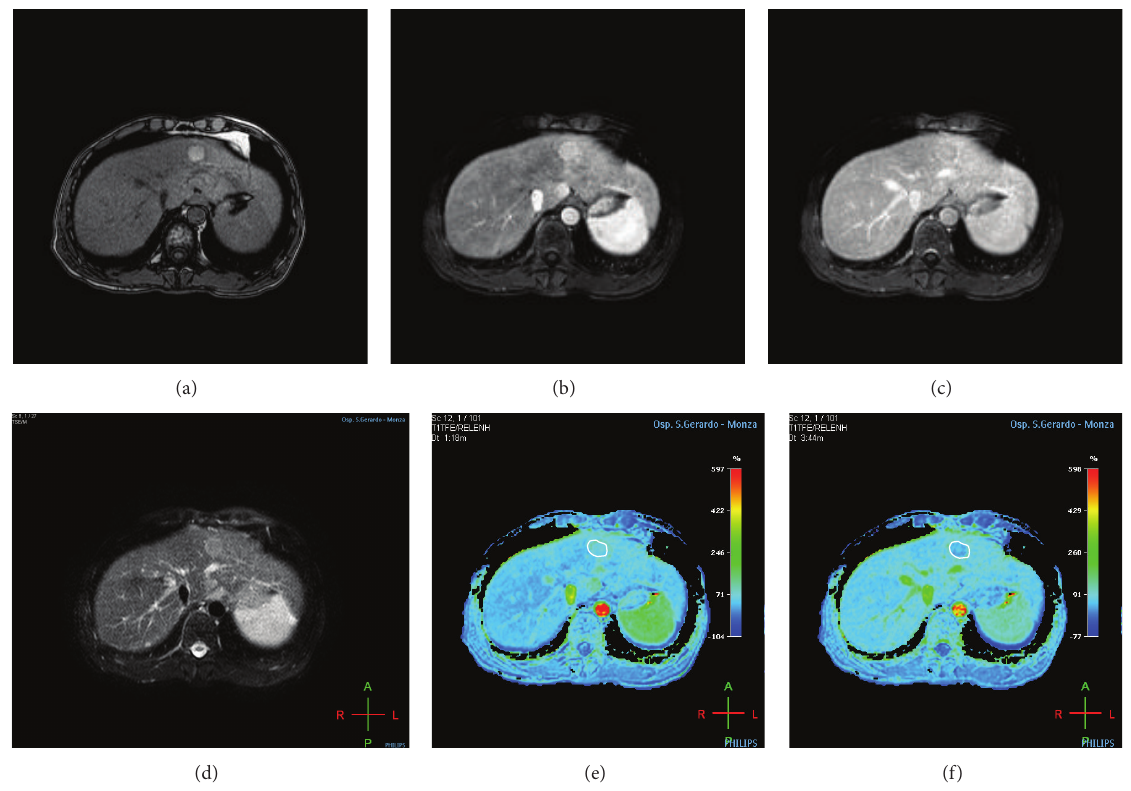
Figure 3: An 81-year-old man with liver cirrhosis-HCV related and with histologically proven HCC in the second segment. DCE-MR was performed to establish the presence of focal liver lesion. (a) Axial T1-weighted in-phase echo-gradient sequence shows a hyperintense nodular area in the second segment, due to presence of glycogen deposition. (b, c) Axial arterial and delayed postcontrast phase MR images show in arterial phase the presence of increased enhancement of nodular lesion, followed by washout in delayed phase. (d) Axial T2 fat-sat weighted sequence shows a weakly hyperintense nodular area in the second segment. (e, f) On colour perfusion maps (Relative Arterial Enhancement and Relative Late Enhancement, resp.) the ROIs (ROI contouring the boundaries of the lesion) were positioned on nodular lesion, and the corresponding perfusion maps show a hypervascular area, characterized by a different colour compared to the surrounding liver parenchyma with hypointensity signal in perfusion maps created for the delayed phase